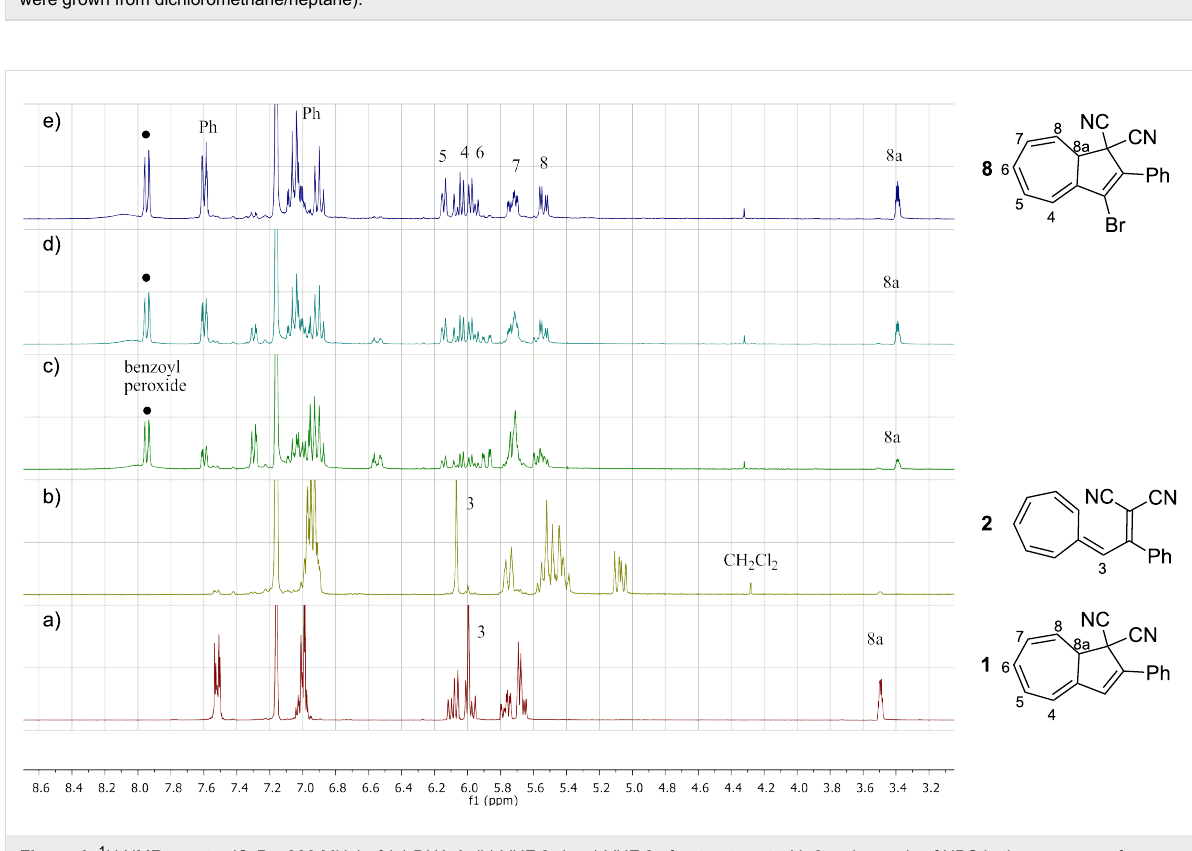
Figure 4: 1 H NMR spectra (C 6 D 6 , 300 MHz) of (a) DHA 1 ; (b) VHF 2 ; (c–e) VHF 2 after treatment with 2 molar equiv of NBS in the presence of benzoyl peroxide and irradiation for 5, 15, and 35 min,